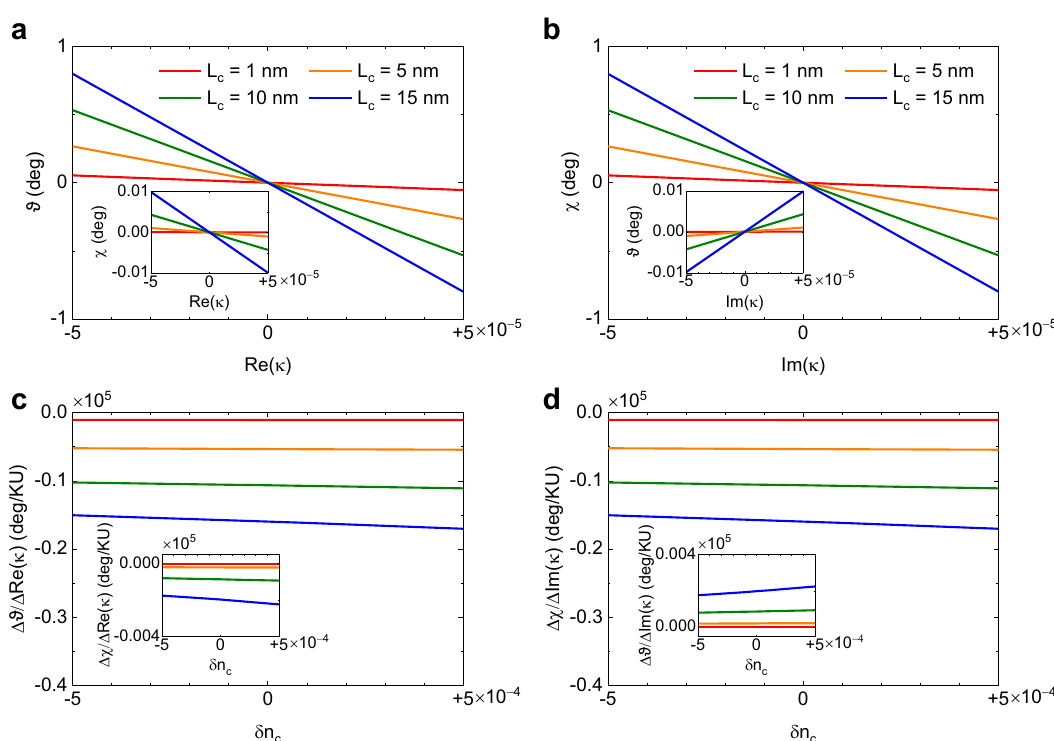
Fig. 4 Sensitivity of chirality-dependent optical rotation ϑ and ellipticity angle χ for different chiral layer thicknesses. a Optical rotation ϑ and ellipticity angle χ (inset) as a function of chirality parameter κ ranging from − 5 × 10 − 5 to 5 × 10 − 5 (purely real κ ). b χ and ϑ (inset) as a function of κ ranging from − 5 × 10 − 5 i to 5 × 10 − 5 i (purely imaginary κ ). ϑ and χ are obtained from the CPA-locked S C with the average refractive index of the chiral layers, n c = 1.33 + 10 − 4 i . c Δ ϑ / Δ Re( κ ) and Δ χ / Δ Re( κ ) (inset) and d Δ χ / Δ Im( κ ) and Δ ϑ / Δ Im( κ ) (inset) as a function of refractive index perturbation δ n c ranging from − 5 × 10 − 4 to 5 × 10 − 4 for the CPA-locked S C with n c = (1.33 + δ n c ) + 10 − 4 i . Different values of chiral layer thickness L c are represented by colors. KU stands for the unit of κ and CPA is an acronym for coherent perfect